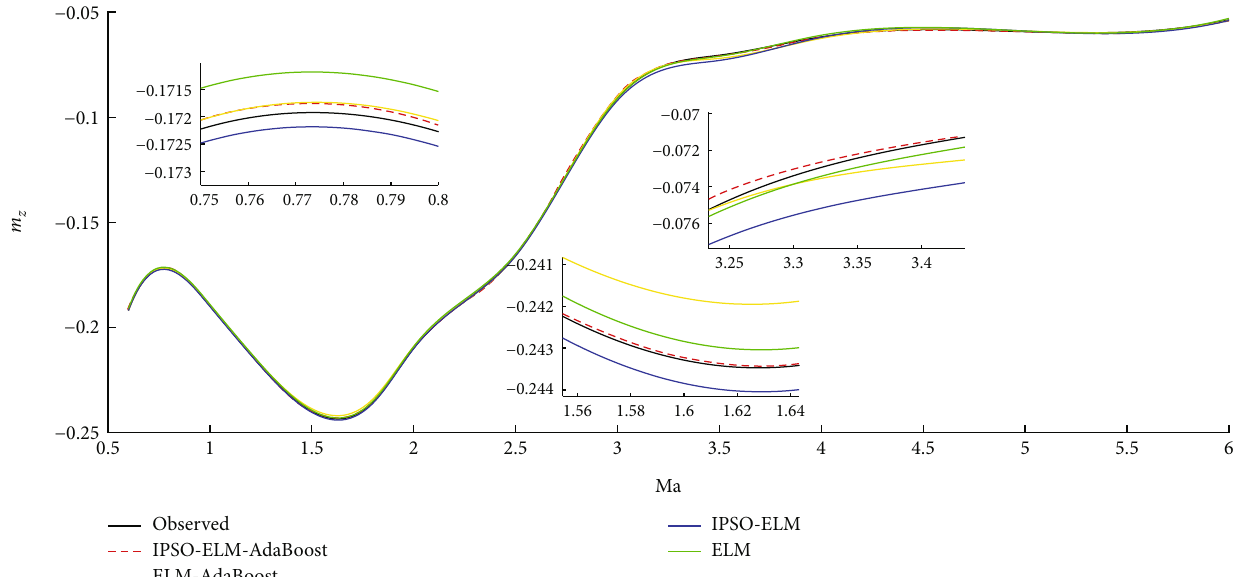
Figure 9: Identi fi cation results of c